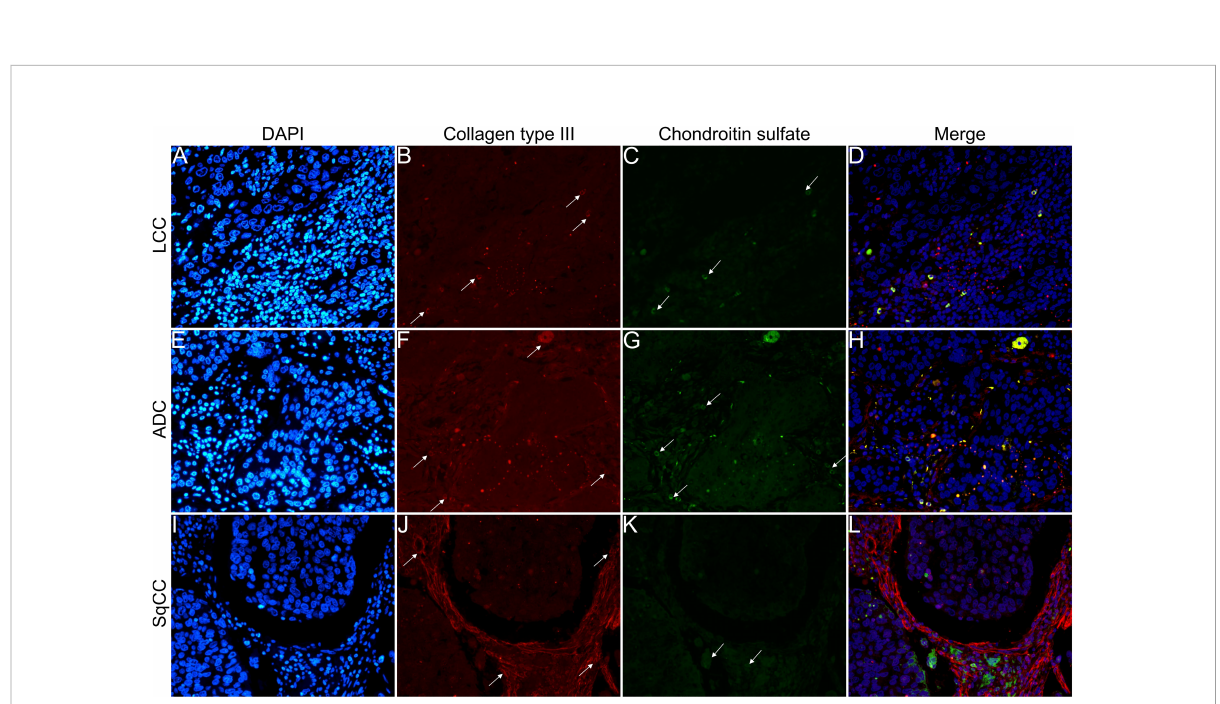
FIGURE 7 Co-analysis of immuno fl uorescence of chondroitin sulfate (green; C , G , K ) and collagen type III (red; B , F , J ) in three different histological subtypes of non-small cell lung carcinoma (N=120). The stained nuclei are represented in blue (DAPI; A , E , I ). Images D , H , L represent the merge of the same fi eld of these three stains. White arrows indicate positive expression of the markers. Original magni fi cation: 40x. LCC, large cell carcinoma; ADC, lung adenocarcinoma; SqCC: lung squamous cell carcinoma.